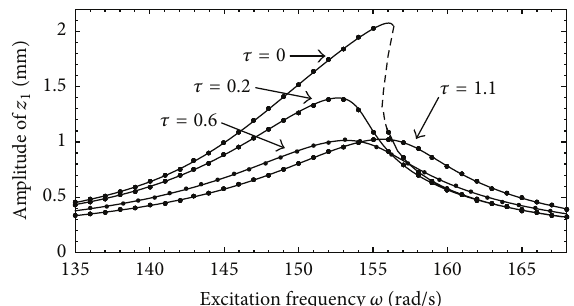
Figure 6: The response-frequency curves of the master structure when 𝜏 = 0 , 𝜏 = 0.2 , 𝜏 = 0.6 , and 𝜏 = 1.1 . Solid lines are solved by HBM while dots are solved by numerical